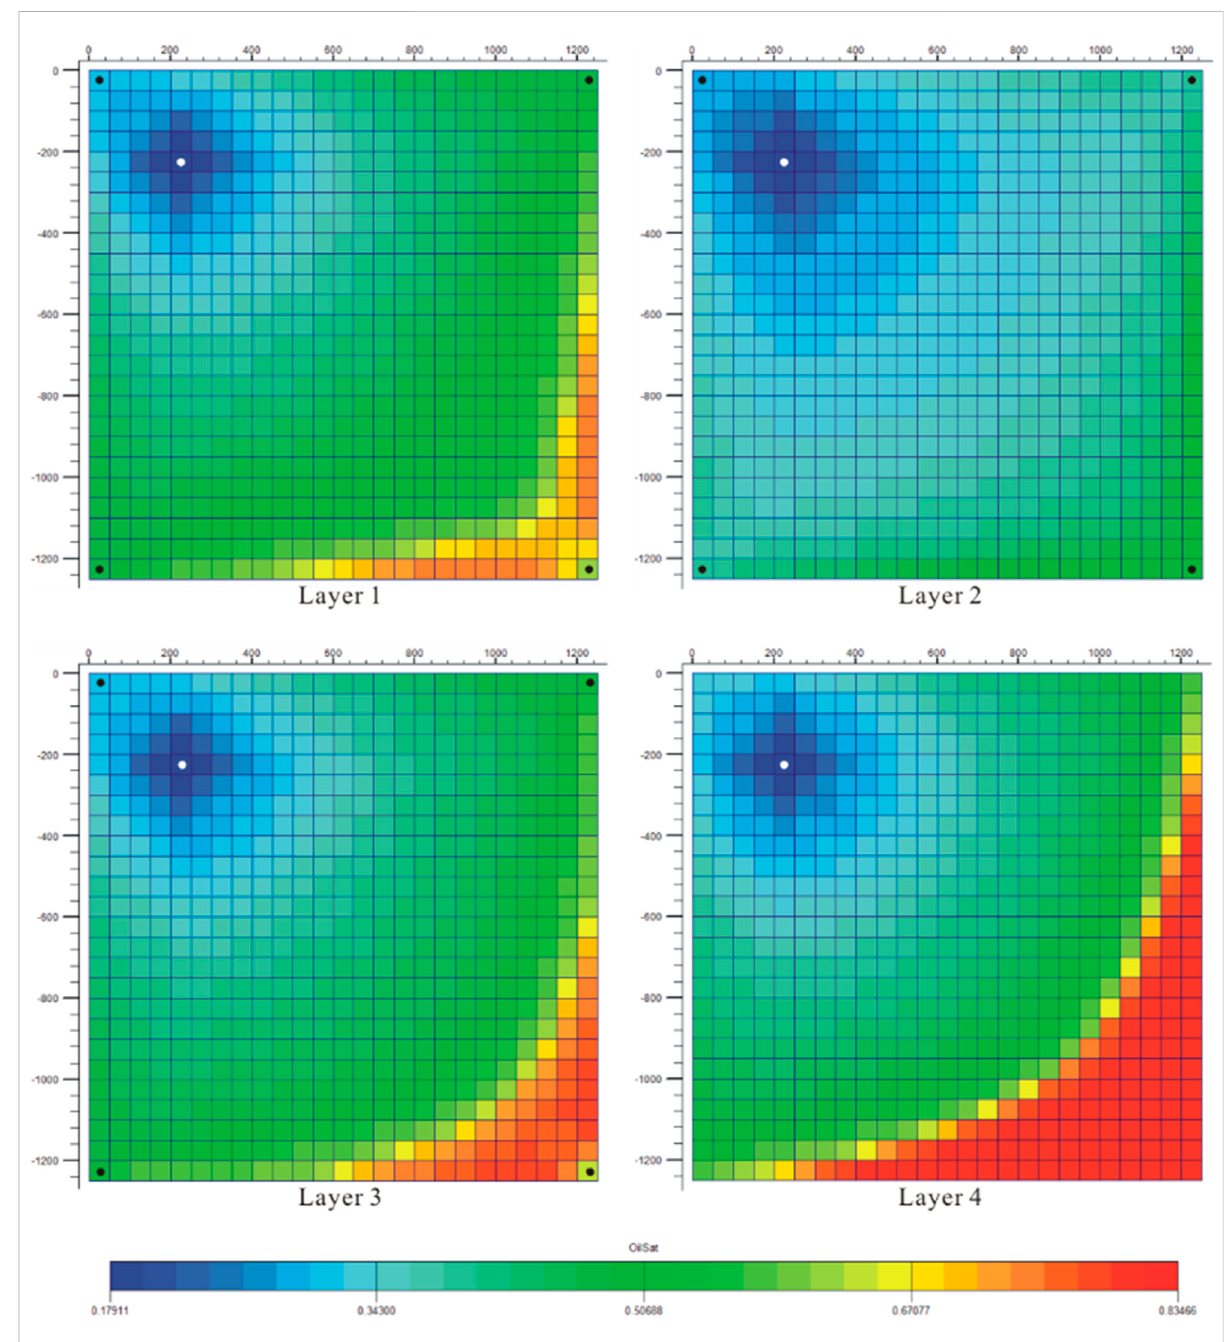
FIGURE 3 Initial well location and the corresponding fi nal oil saturation pro fi les for the synthetic